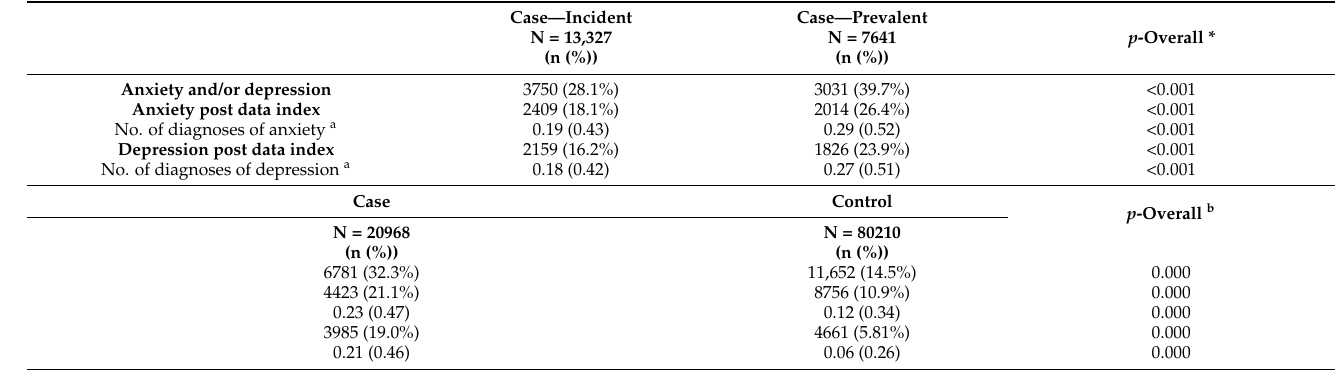
Table 2. Prevalences and numbers of anxiety and depression diagnoses in patients with and with- out